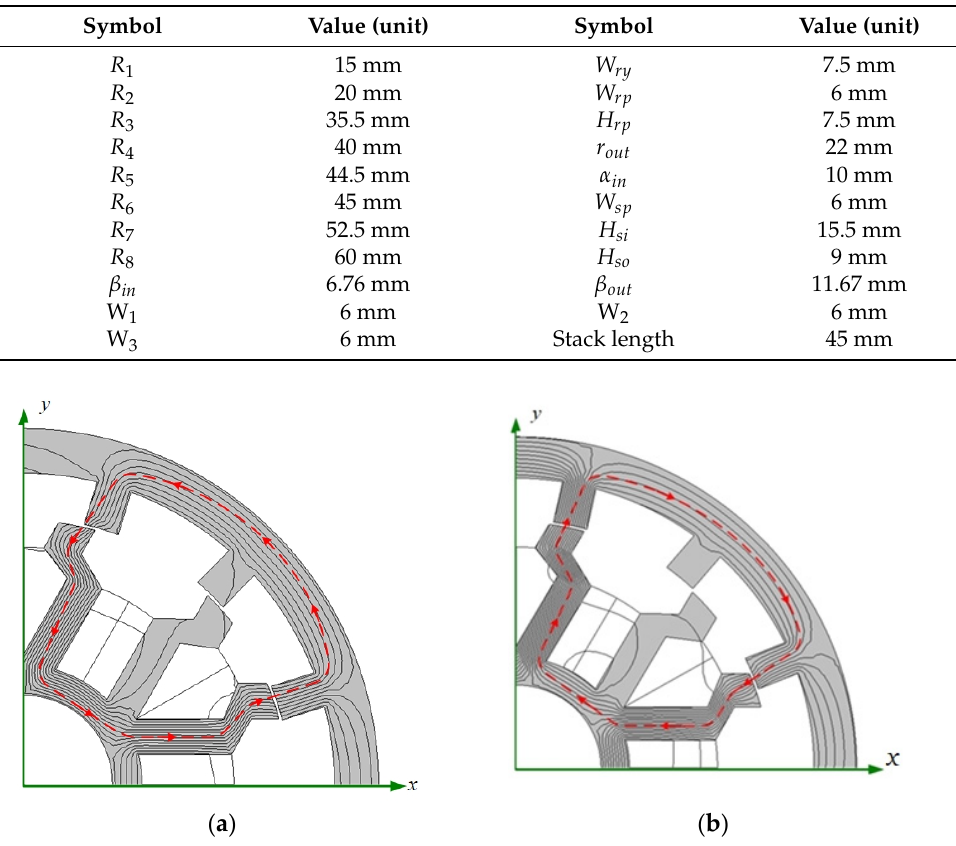
Figure 3. Operating principle of OR-FEFSM ( a ) positive maximum flux and ( b ) negative maximum flux.